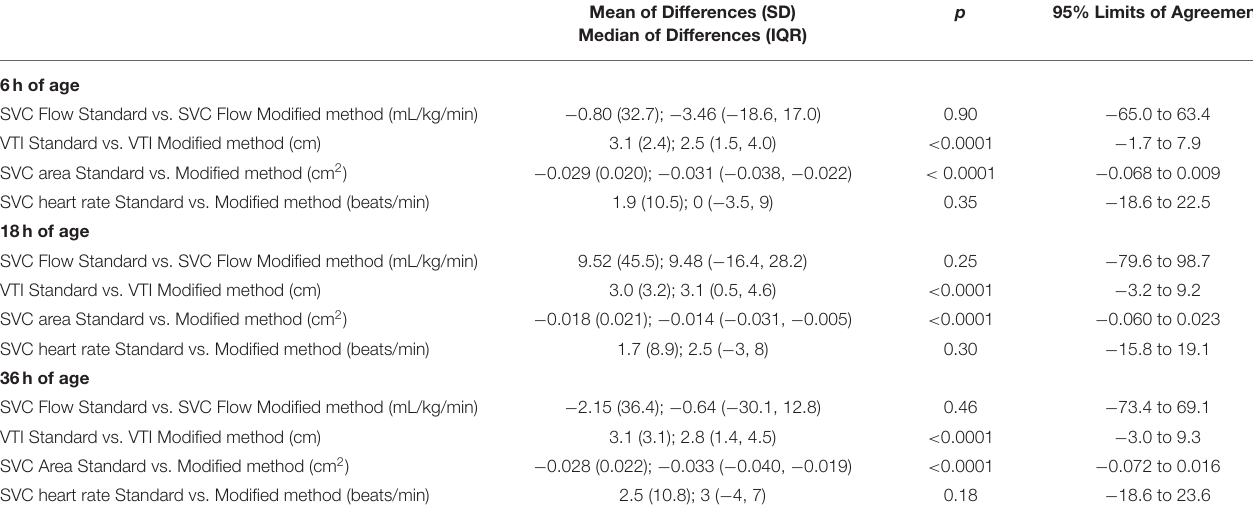
TABLE 4 | Mean and median difference (bias) between the standard and modified method of superior vena cava (SVC) flow measurement with p -values (paired-t or Wilcoxon’s ranked signed rank test as appropriate) and 95% limits of agreement, including cross sectional area of SVC, Velocity Time Integral (VTI) and heart rate at all three time